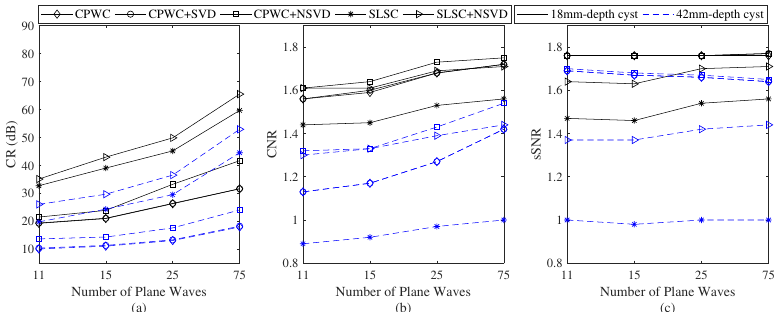
Figure 20. Effect of the number of compounding angles on ( a ) CR, ( b ) CNR, and ( c ) sSNR in simulated cysts target